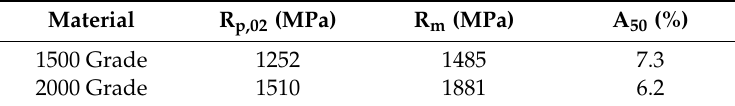
Table 2. Mechanical properties of the materials under investigation.